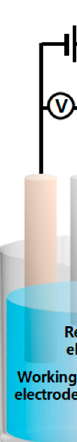
Figure 2. Three-electrode system schematic.